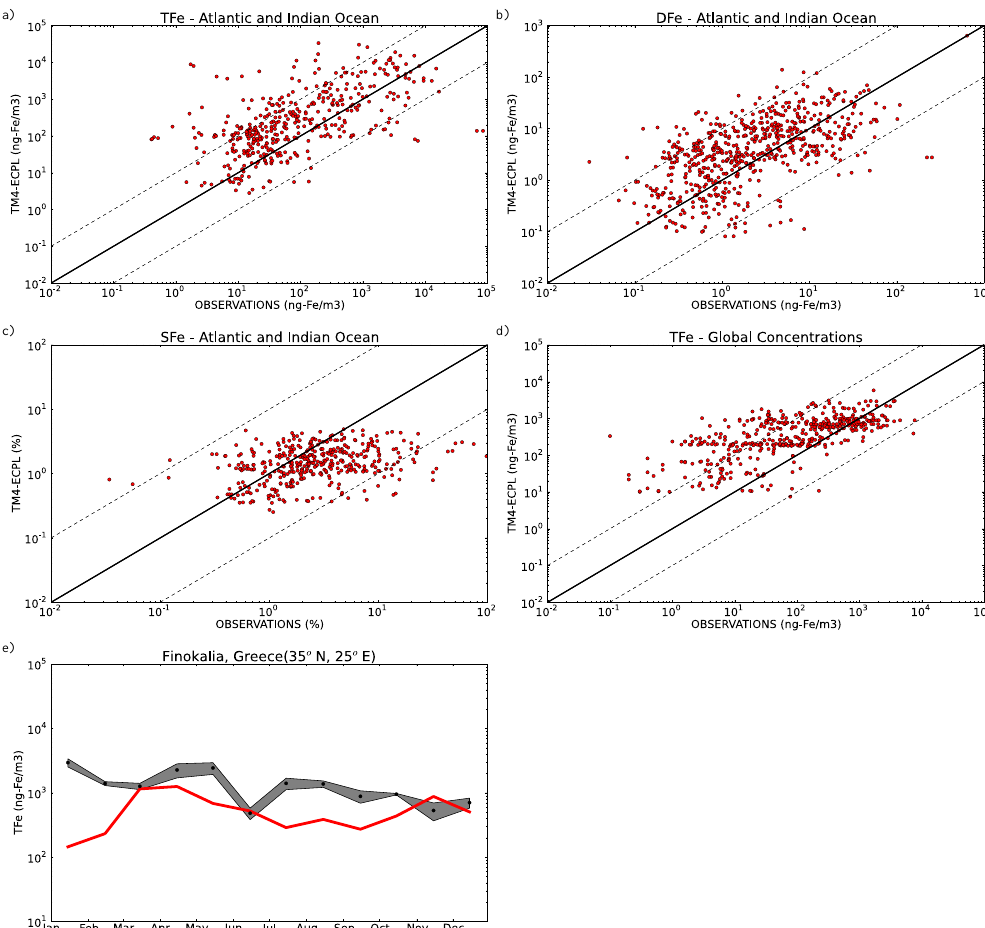
Figure 5. Log - scatter plot of model (y-axis) comparison with cruise observations over the Atlantic Ocean (Baker et al., 2013) and Indian Ocean (Witt et al., 2006) ( x axis) for (a) TFe, (b) the DFe and (c) the SFe fractions in ambient aerosols, (d) TFe comparison with global observations from Mahowland et al. (2005) and (e) time series of monthly variation of TFe in ambient aerosols at Finokalia station (Koulouri et al., 2008); monthly mean observations are marked with dots, their variability is shown with the dashed area, model results are plotted by the black continuous line. In the scatter plots, the continuous black line shows the 1 : 1 correlation, while the dashed lines show the 10 : 1 and 1 : 10